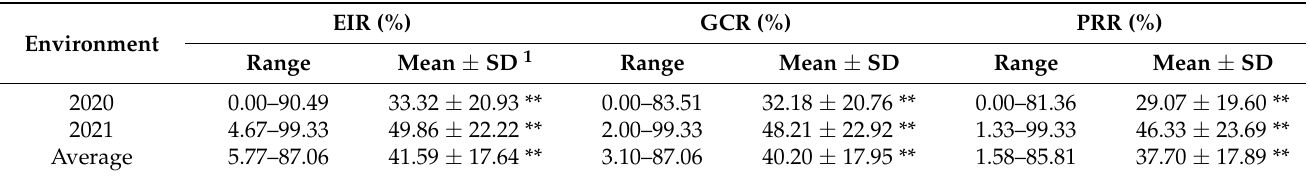
Table 1. Phenotypic performance of somatic regeneration traits in the maize segregating populations.